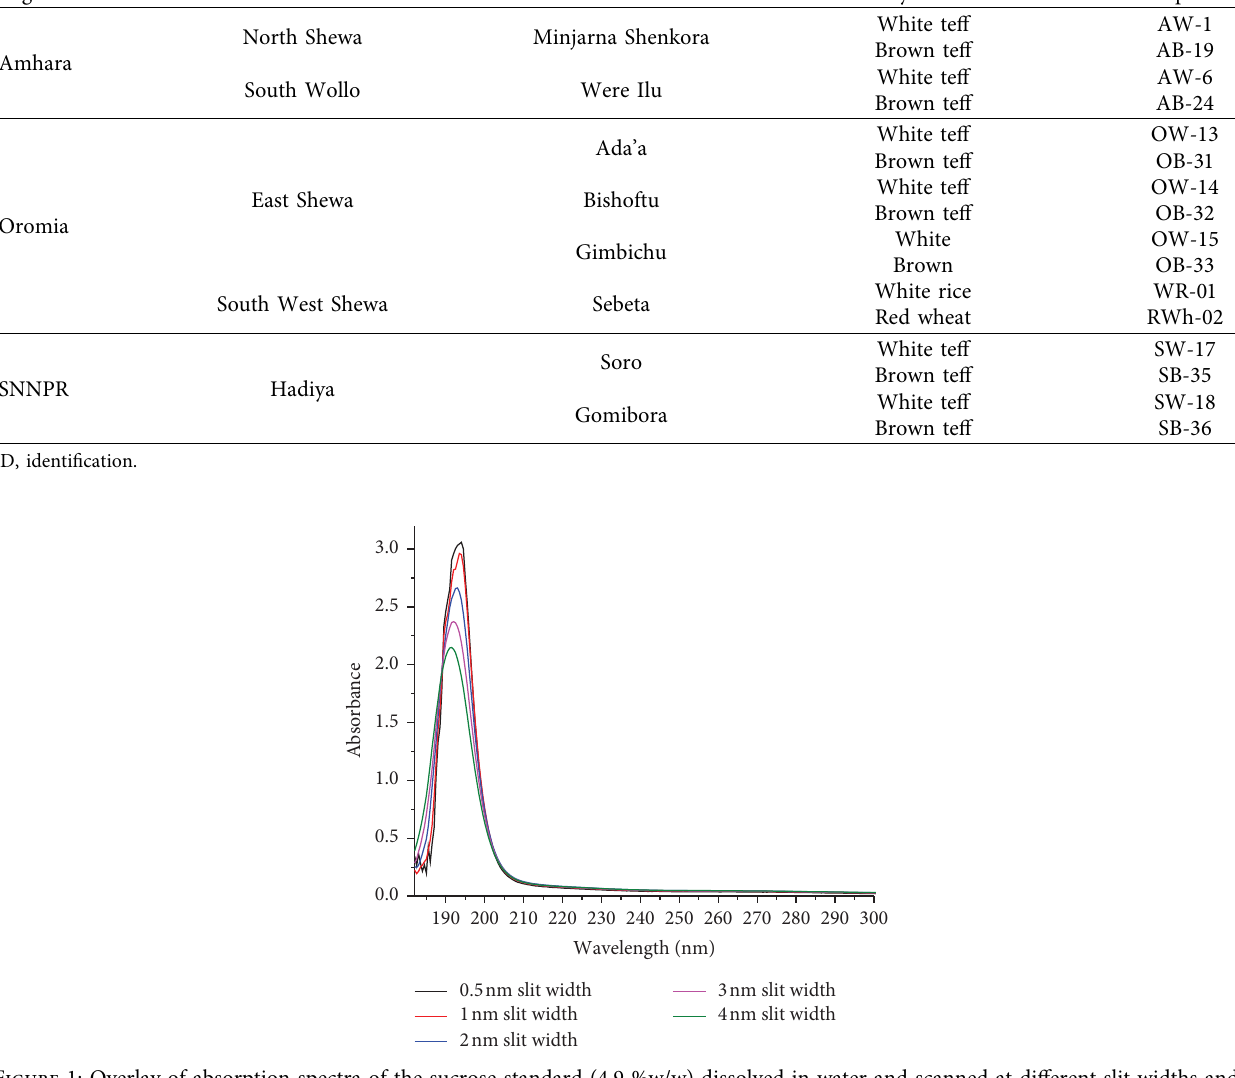
Figure 1: Overlay of absorption spectra of the sucrose standard (4.9 %w/w) dissolved in water and scanned at diferent slit widths and response time (0.52